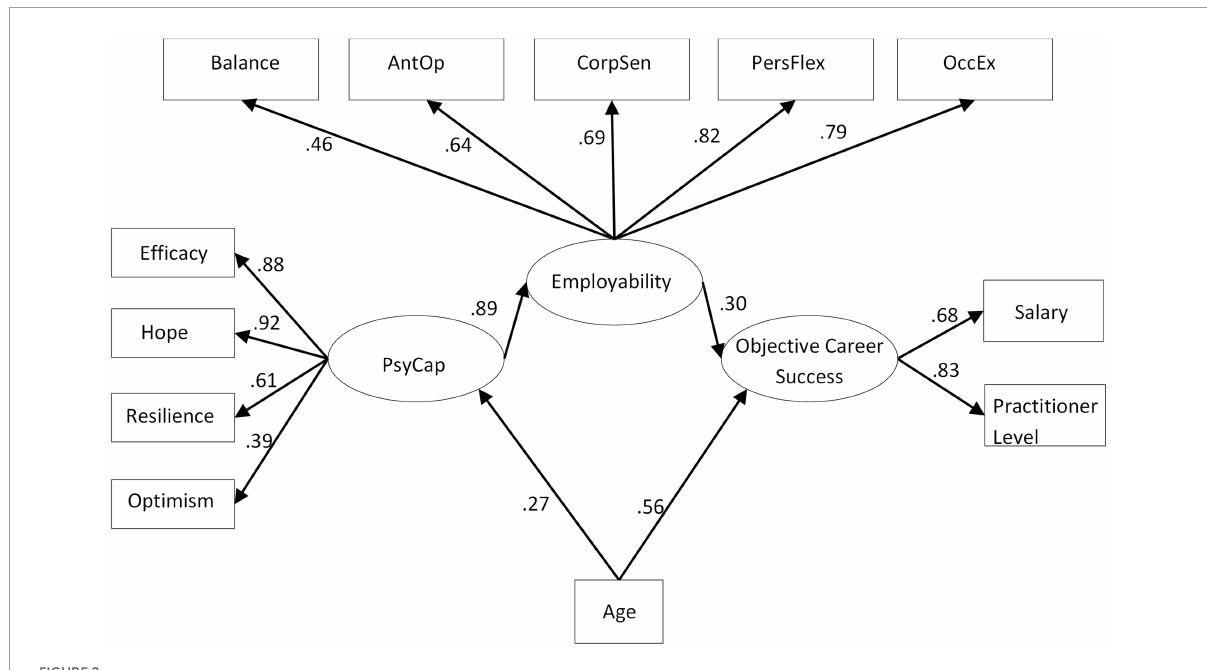
FIGURE2 Significant structural paths for alternative model with employability as a full mediator between PsyCap and objective career success.